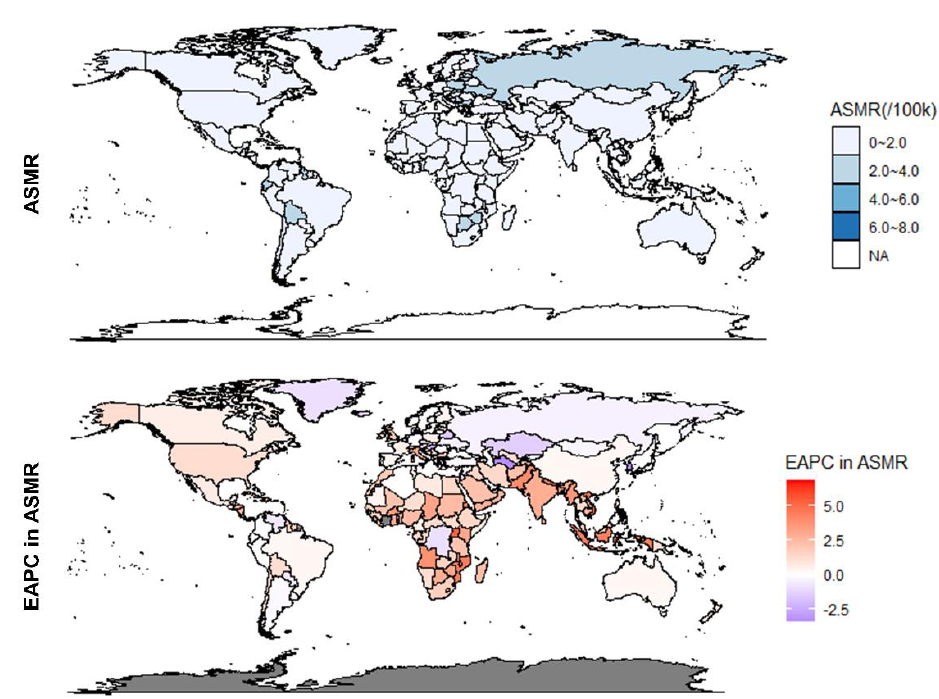
Figure 2. ASMR in 2019 for 204 countries and regions and their EAPC between 1990 and 2019. ASMR, Age-standardized mortality rate; EAPC, Estimated annual percentage change.